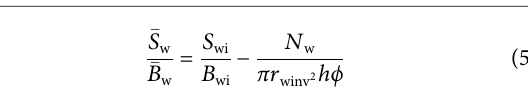
FIGURE 6 | The effect of non-Darcy fl ow on gas wells with two-phase fl ow of gas and water.